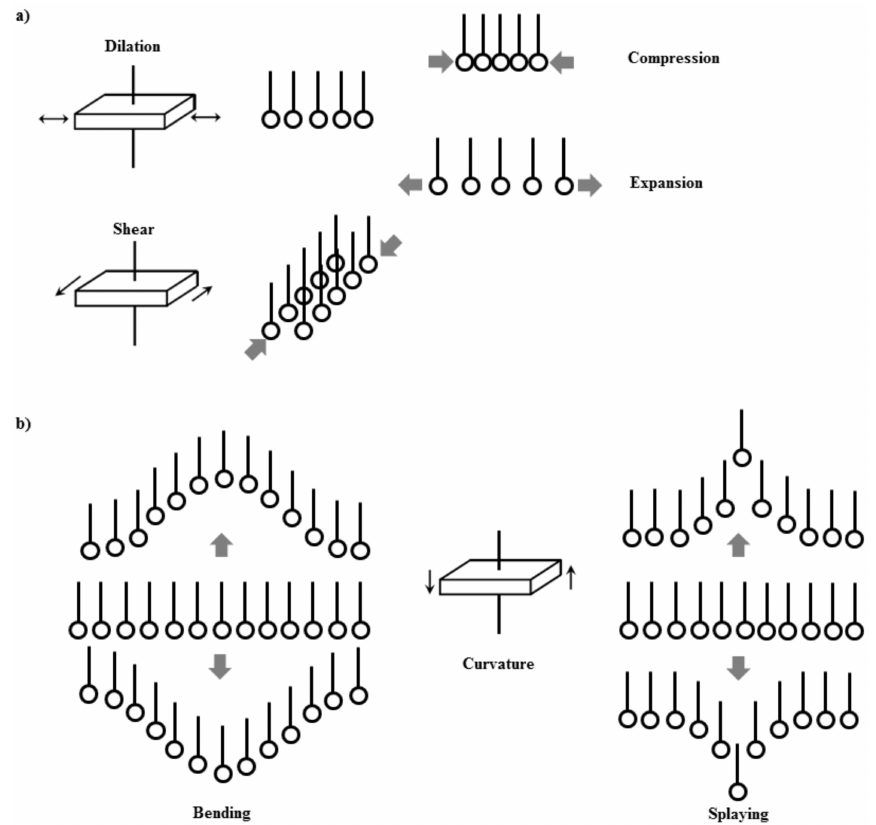
Figure 1. Sketch of different surface relaxation modes: ( a ) in-plane-modes (dilation and shear) and ( b ) out-of-plane modes (bending and splaying). Reprinted from Maestro and Guzm á n [34],